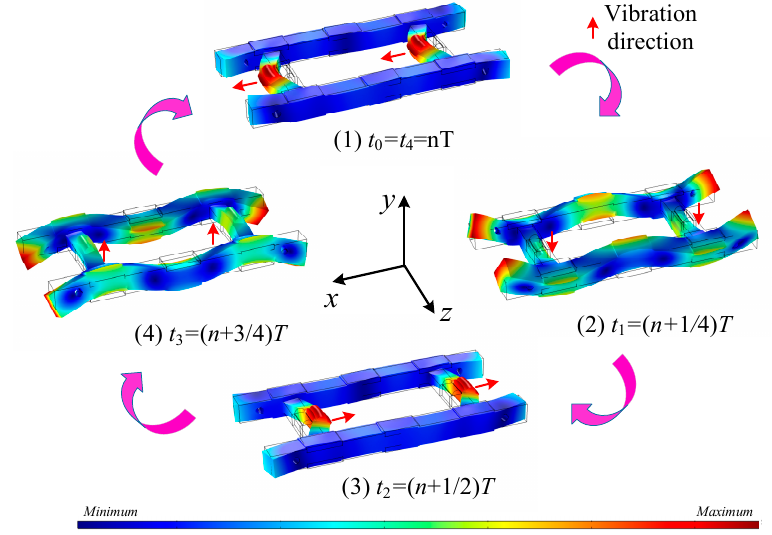
Figure 5. Harmonic simulation results of the framed piezoelectric actuator during one excitation period.